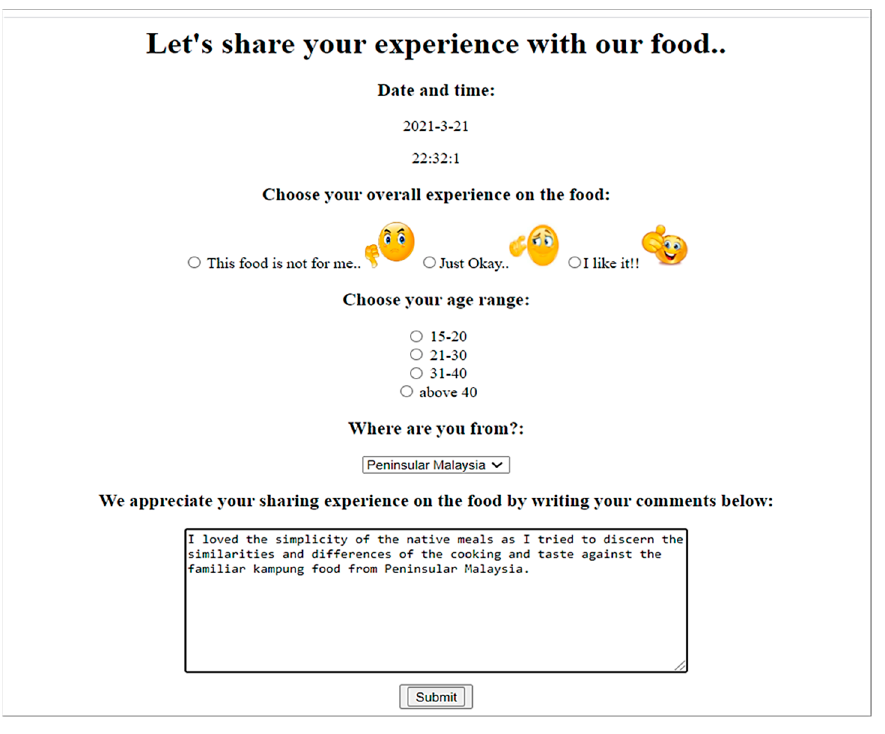
Figure 10. The food recognition module.